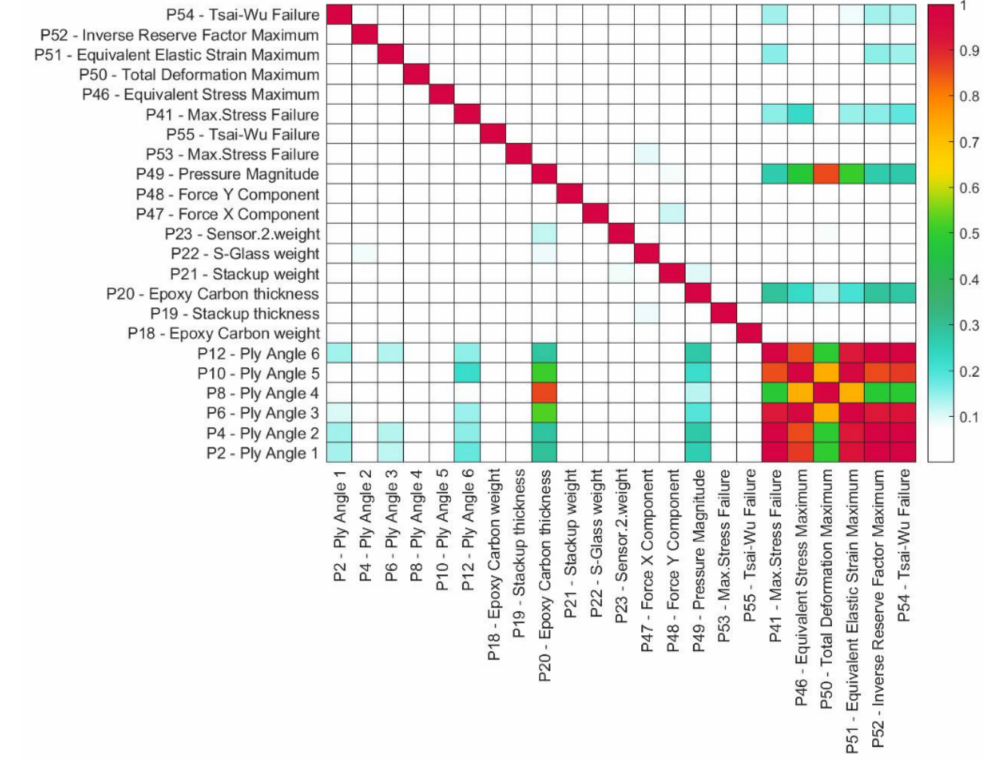
Figure 22. Parametric determination matrix.